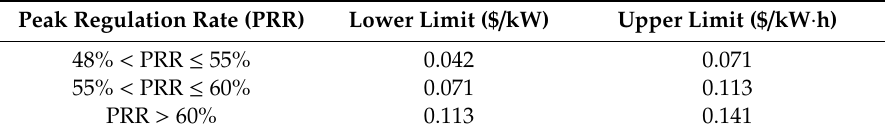
Table 5. Quotation intervals for peak regulation.